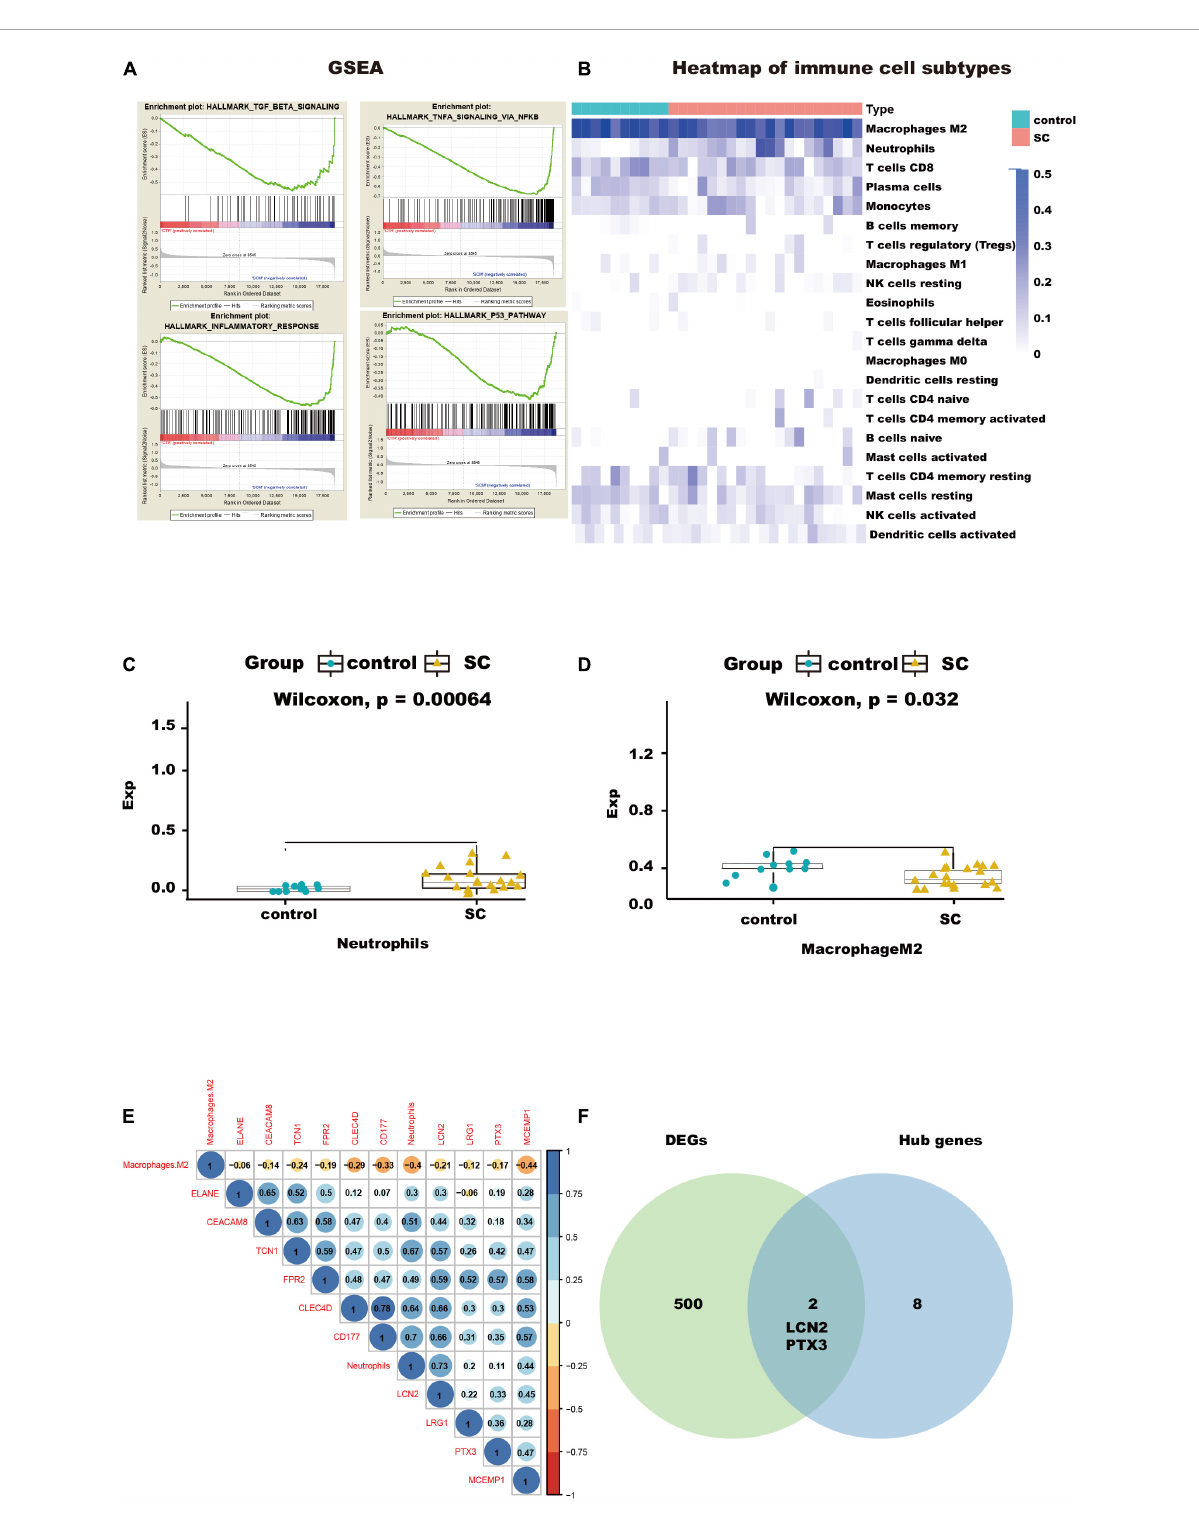
FIGURE4 Immunocyte infiltration analysis and potential immunocyte subtype detection. (A) This diagram shows the immune-related pathways by gene set enrichment analysis (GSEA) analysis. (B) This heatmap shows the immunocyte infiltration difference between SC and control heart samples. (C,D) Box plots presenting significantly infiltrated immunocyte subtypes, neutrophils, and M2 macrophages. (E) This correlated heatmap shows the relationship between immunocytes and hub genes. (F) Intersection between DEGs and hub genes, identifying the key genes, LCN2, and